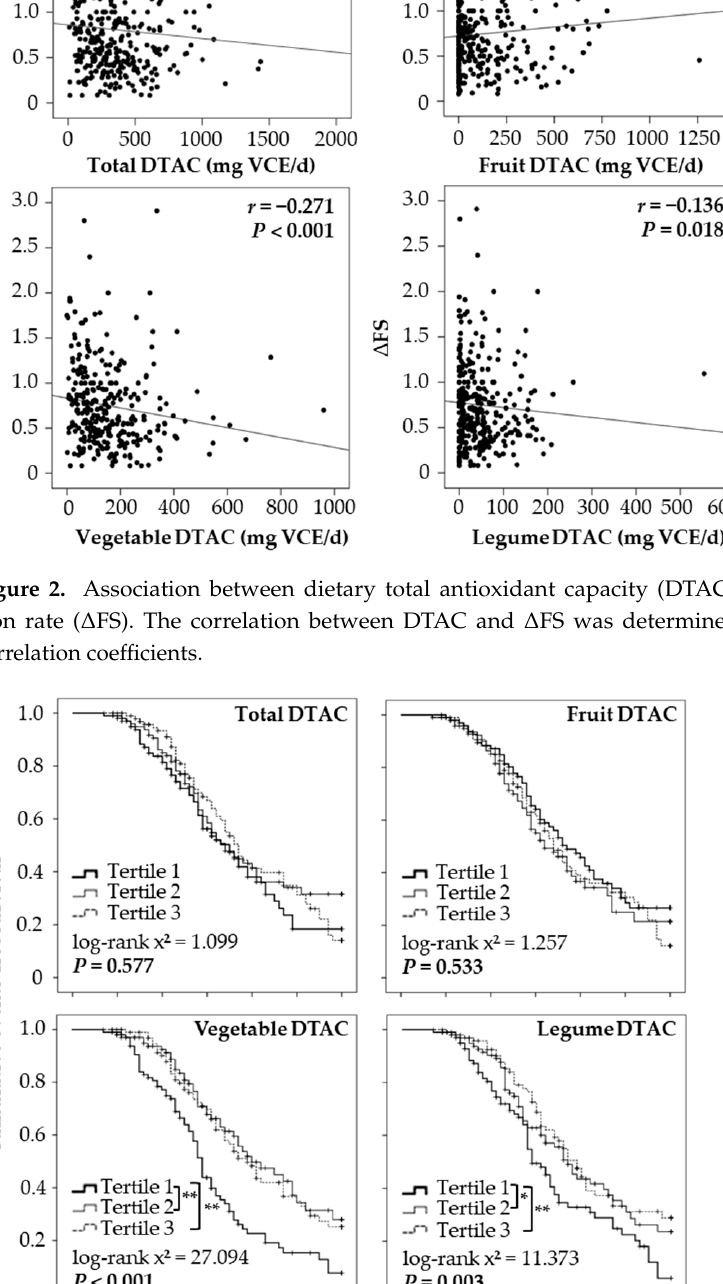
Figure 2. Association between dietary total antioxidant capacity (DTAC) and disease progression rate ( Δ FS). The correlation between DTAC and Δ FS was determined by Spearman’s rank correlation coefficients.